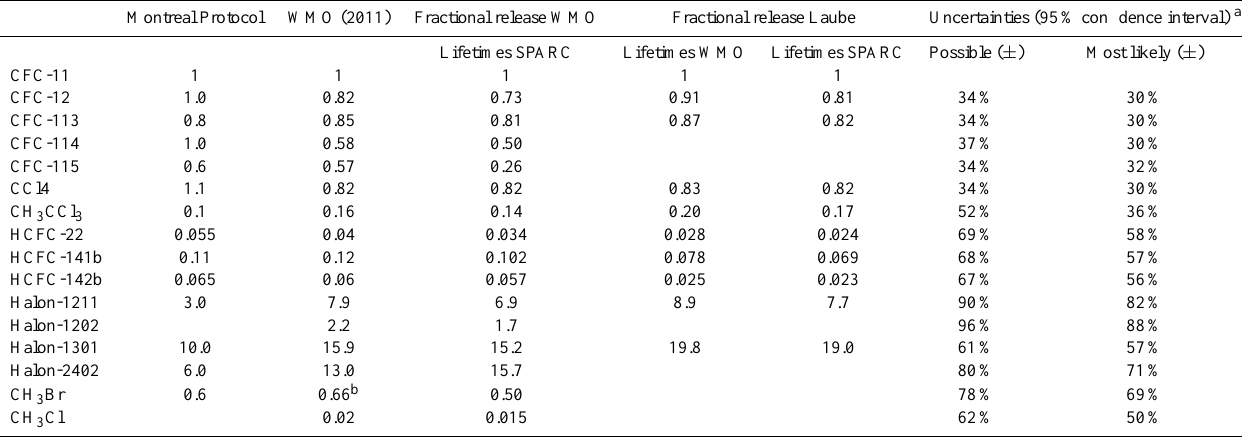
Table 3. ODPs and their uncertainties. The ODPs shown are those included in the Montreal Protocol, the semiempirical values reported in WMO (2011), and the semiempirical values calculated here using the lifetimes from SPARC (2013) and fractional release values from WMO (2011) and Laube et al. (2013).